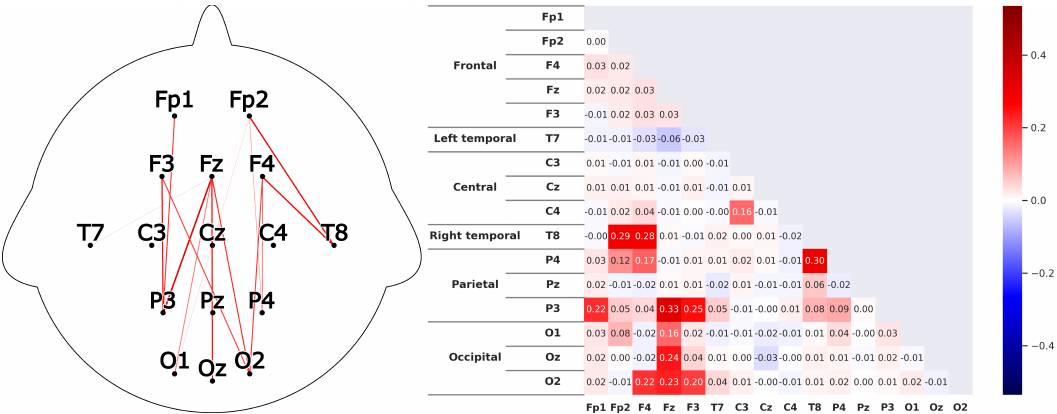
Figure 15. Difference of the results between the HKT leader and the BSC leader as described in Figure